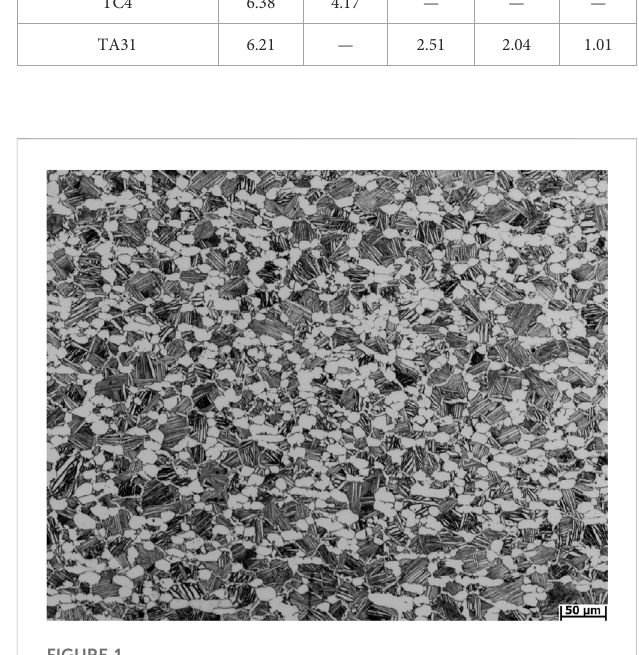
FIGURE 1 Microstructure of the tested TA31 titanium